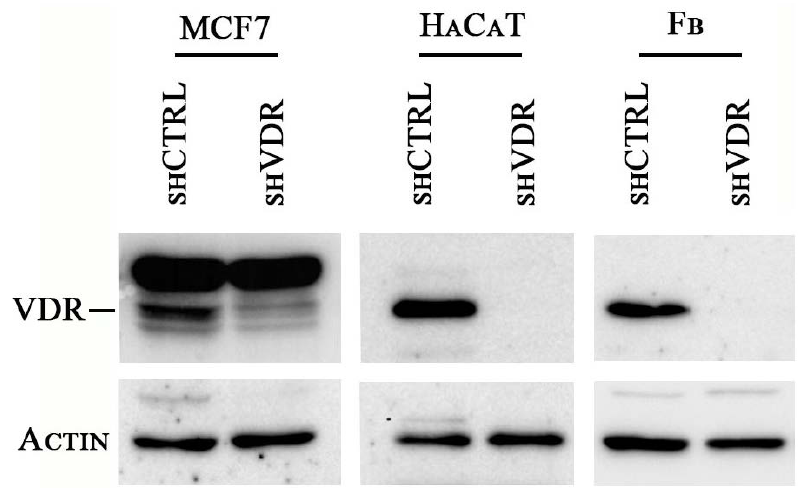
Figure 1. shRNA-mediated Vitamin D receptor (VDR) knockdown in the human cells MCF7, HaCaT, and primary fibroblasts (Fb) abrogates VDR expression. The cells were silenced by lentiviral infection with an shRNA against VDR (shVDR) or with a scrambled non-targeting shRNA as control (shCTRL). Seven days after infection, VDR expression was evaluated in the cellular whole extracts by western blot analysis. Actin was detected as an internal control for protein loading.